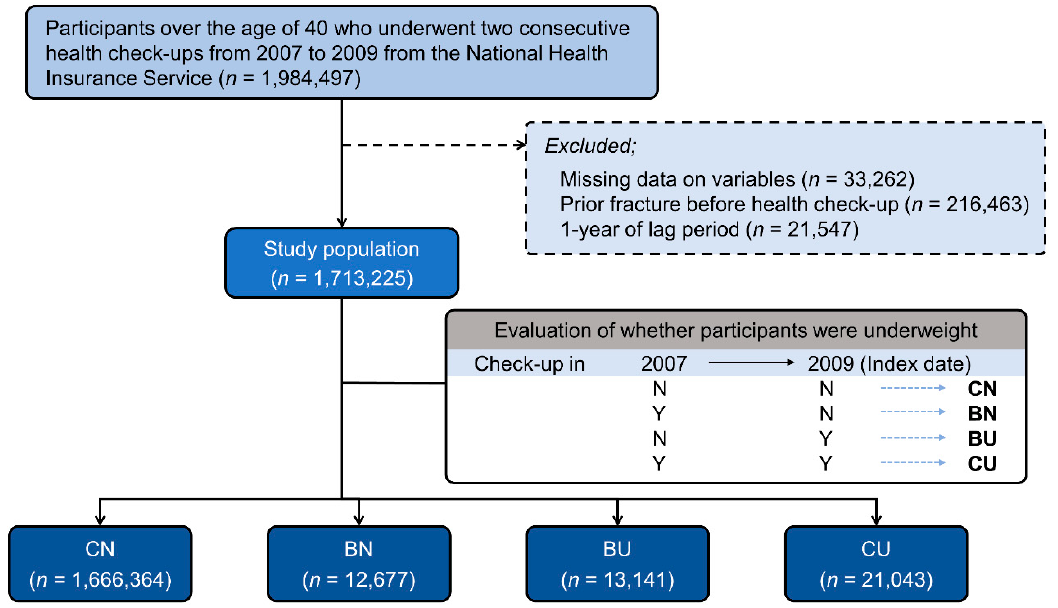
Figure 1. Flow chart of the present study. Y, yes; N, no; CN, consistent non-underweight; BN, became non-underweight; BU, became underweight; CU, consistent underweight.